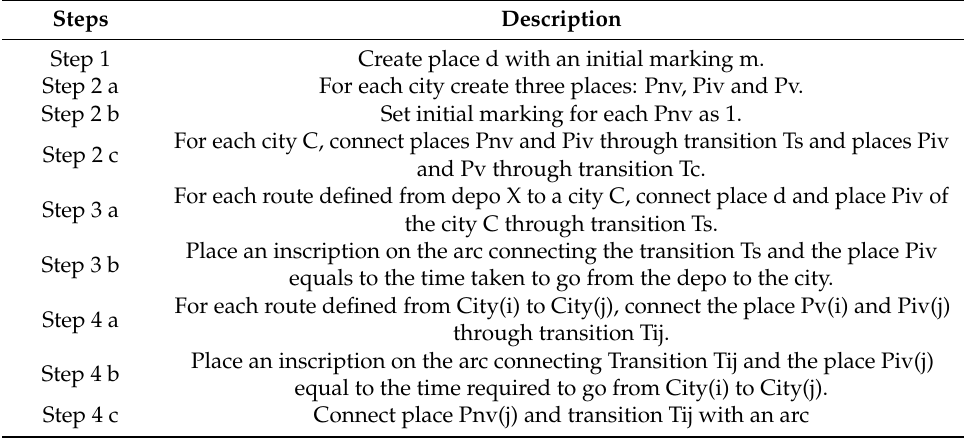
Table 3. Algorithm to map mTSP onto CPN.